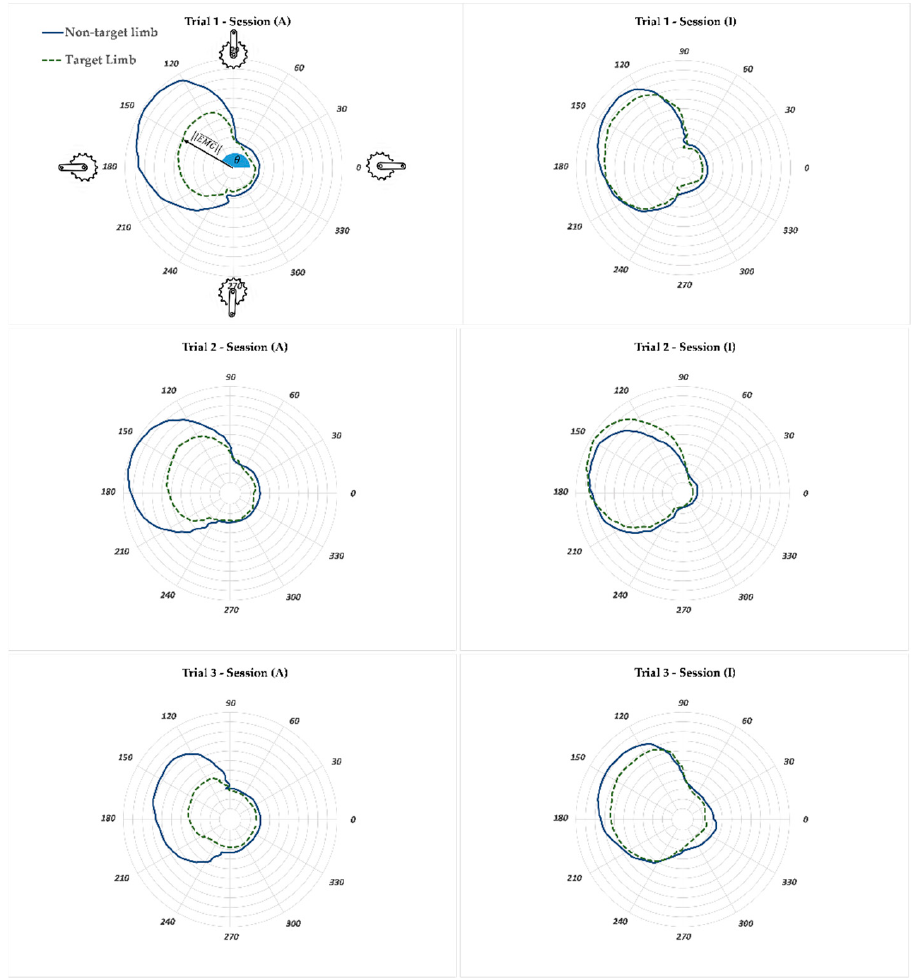
Figure 9. The polar plot of normalized VL muscle activity of target ( right ) and non-target ( left ) legs for Trials 1 to 3. The VL muscle was excited more than 50% of its respective maximum during the downstroke, i.e., crank angle 90–240° (±10° SD). During session (I), when the APAD was inactive, the left and right VL muscle activity profiles overlapped, indicating that the APAD did not assist the non-target leg. The radius (cid:12) EMG (cid:12) , and angle θ represent the magnitude of normalized EMG and the crank angle, respectively.